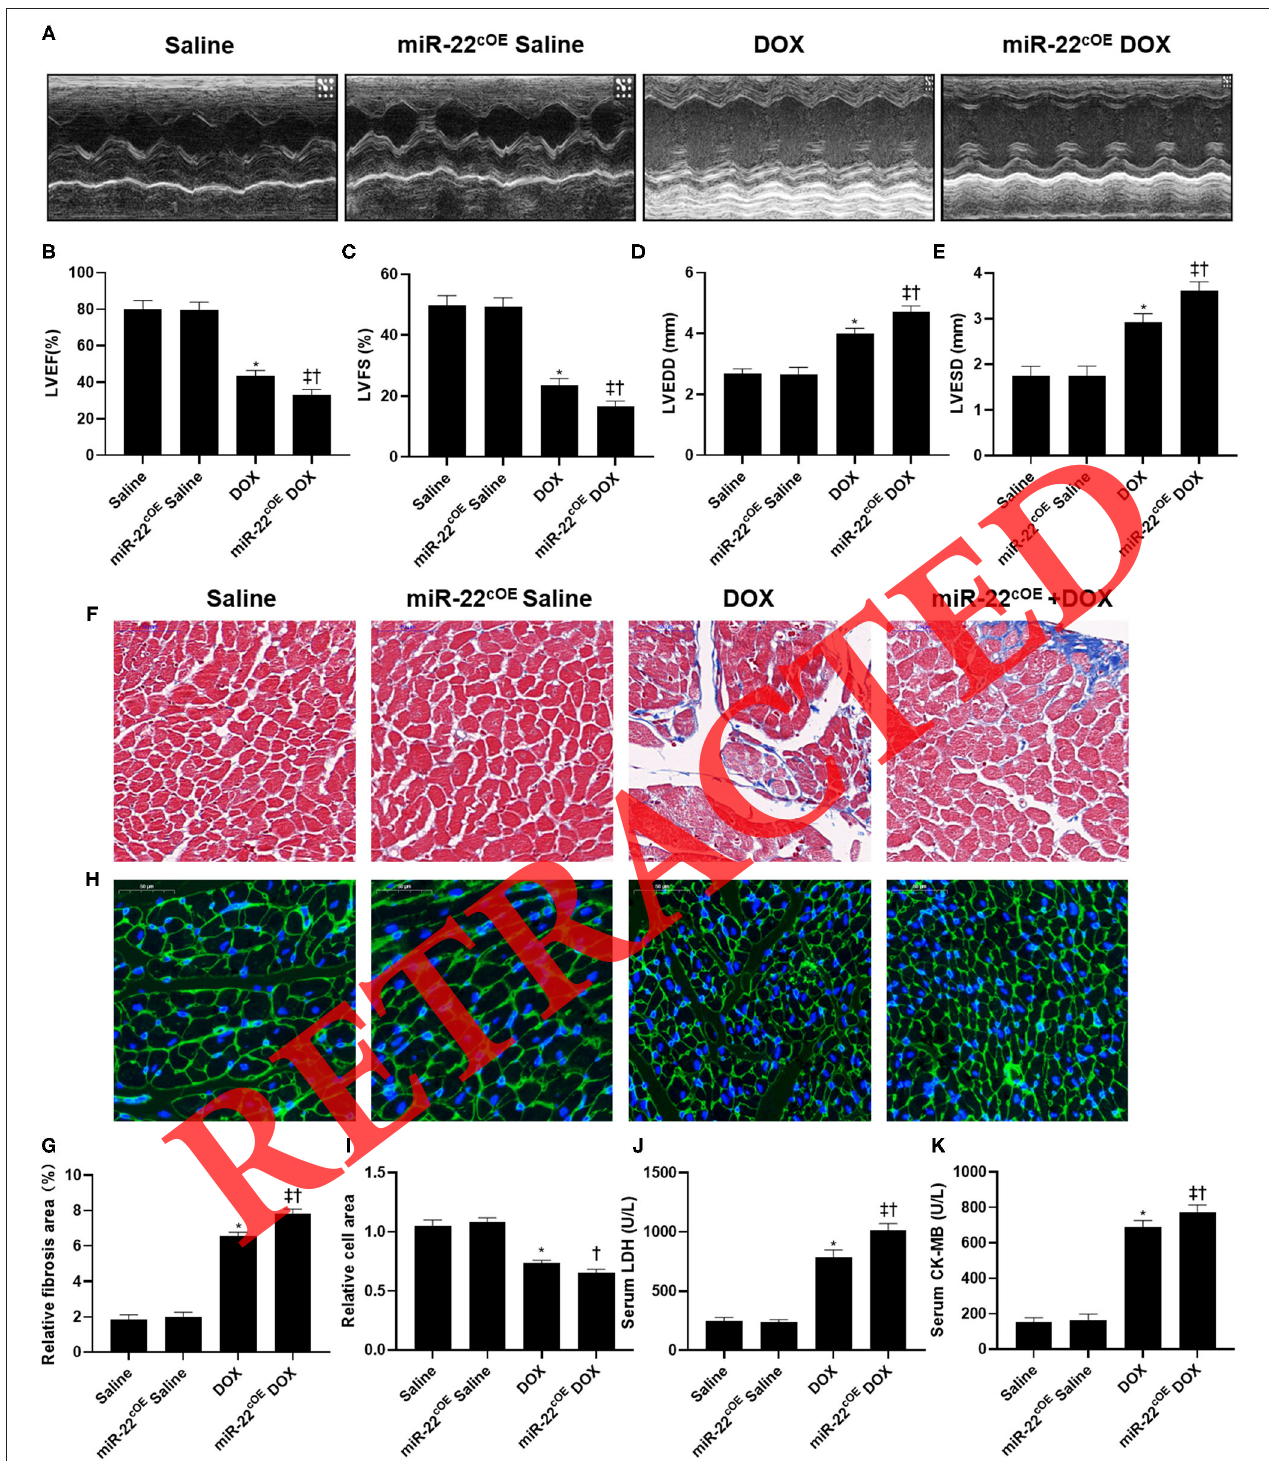
FIGURE 4 | Overexpressing miR-22 aggravates cardiac dysfunction in DOXIC. (A) M-mode Echocardiograms representative image ( n = 6), (B) LVEF, (C) LVFS, (D) LVESD, (E) LVEDD, (F) Representative images of Masson staining, (G) Relative collagen area, (H) Representative WGA staining images, (I) Relative cell area, (J) serum LDH ( n = 6), (K) serum CK-MB ( n = 6), Data were shown as mean ± SEM. * P < 0.05 vs. saline group, ‡ P < 0.05 vs. DOX group, † P < 0.05 vs. miR-22 cOE group. All the experiments were repeated three times.